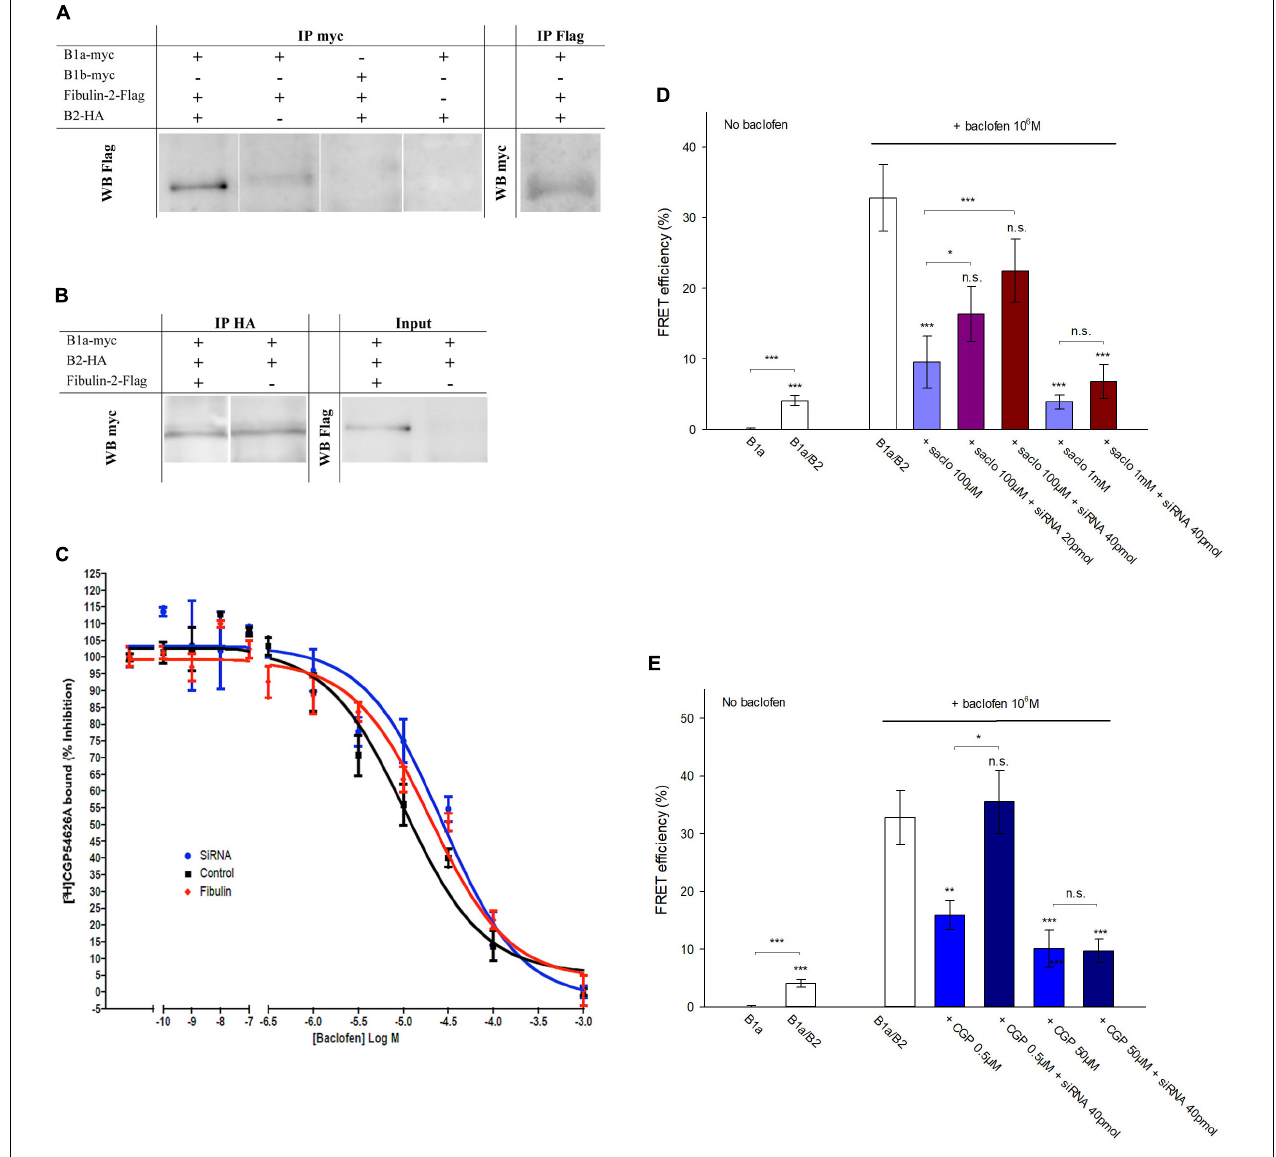
FIGURE 3 | Fibulin-2 interacts with GABAB and alters antagonist-induced effects in vitro . (A) Fibulin-2-Flag co-immunoprecipitates with myc-GABAB1a (lane 1, left panel) in COS-7 cells. In the absence of HA-GABAB2, the co-immunoprecipitation is largely reduced (lane 2, left panel). Fibulin-2-Flag does not co-immunoprecipitate with the GABAB1b subunit (lane 3, left panel). No signal is observed in the absence of myc-GABAB1a or fibulin-2-Flag (lane 3 and 4, left panel). Conversely, myc-GABAB1a co-immunoprecipitates with fibulin-2-Flag (right panel). IP, immunoprecipitation; WB, Western-Blot. (B) GABAB1a-GFP subunit co-immunoprecipitates with HA-GABAB2 in COS-7 cells in the presence (lane 1, left panel) or in the absence (lane 2, left panel) of fibulin-2-Flag. Fibulin-2-flag transfection actually results in the expression of the protein (right panel). IP: immunoprecipitation; WB: Western-Blot. (C) One site fitting of the [ 3 H]-CGP54626 binding sites (GABAB receptor) inhibited by baclofen in rat primary cell cultures (expressed in % of inhibition). The membrane preparations from cell cultures were incubated with 2 nM [ 3 H]-CGP54626 and increasing concentrations of baclofen. The affinity of the GABAB receptor to the specific agonist baclofen was similar with fibulin-2 ( (cid:7) ); anti-fibulin-2 siRNA ( ) controls ( (cid:4) ). pIC50 control : –5.0 ± 0.1; pIC50 siRNA : –4.6 ± 0.1; pIC50 fibulin : –4.7 ± 0.1. (D) Effects of saclofen on FRET efficiency between GFP-GABAB1a and DsRed-GABAB2 ± baclofen at 10 − 6 M. Baclofen effect is reversed by saclofen at 100 µ M and 1 mM. Application of anti-fibulin-2 (cid:32) siRNA (20 or 40 pmol) suppresses this reversion at 100 µ M dose (*** p < 0.001 “B1a/B2 + saclo100 µ M” vs. “B1a/B2 + saclo100 µ M + siRNA40”). At high dose (1 mM), saclofen remains efficient even in the presence of anti-fibulin-2 siRNA (NS: p > 0.05 “B1a/B2 + saclo1 mM” vs. “B1a/B2 + saclo1 mM + siRNA40”) ( n = 21 cells). * p < 0.05; ** p < 0.01; *** p < 0.001; n.s.: p > 0.05 vs. “B1a/B2 + baclofen” unless indicated. (E) Effects of CGP55845 on FRET efficiency between GFP-GABAB1a and DsRed-GABAB2 ± baclofen at 10 − 6 M. Baclofen effect is reversed by CGP55845 at 0.5 and 50 µ M. Application of anti-fibulin-2 siRNA (40 pmol) suppresses this reversion at 0.5 µ M dose (* p < 0.05 “B1a/B2 + CGP 0.5 µ M” vs. “B1a/B2 + CGP 0.5 µ M + siRNA40”). At high dose (50 µ M), CGP remains efficient even in the presence of anti-fibulin-2 siRNA (NS: p > 0.05 “B1a/B2 + CGP50 µ M” vs. “B1a/B2 + CGP50 µ M + siRNA40”) ( n = 21 cells). * p <